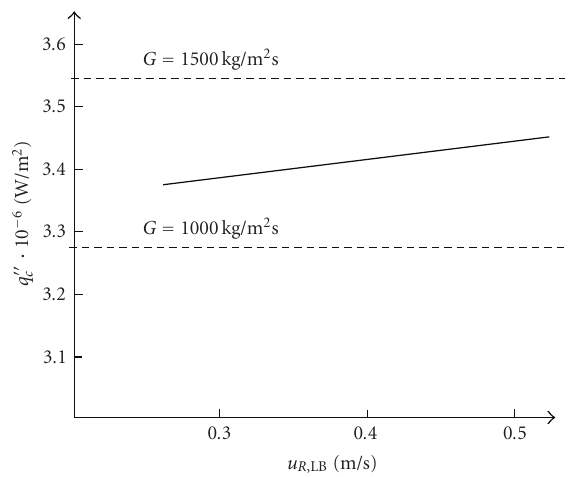
Figure 7: Typical calculated values of critical heat flux, compared against experimental data for subcooled and low-quality boiling of water at 4.5 MPa [17].